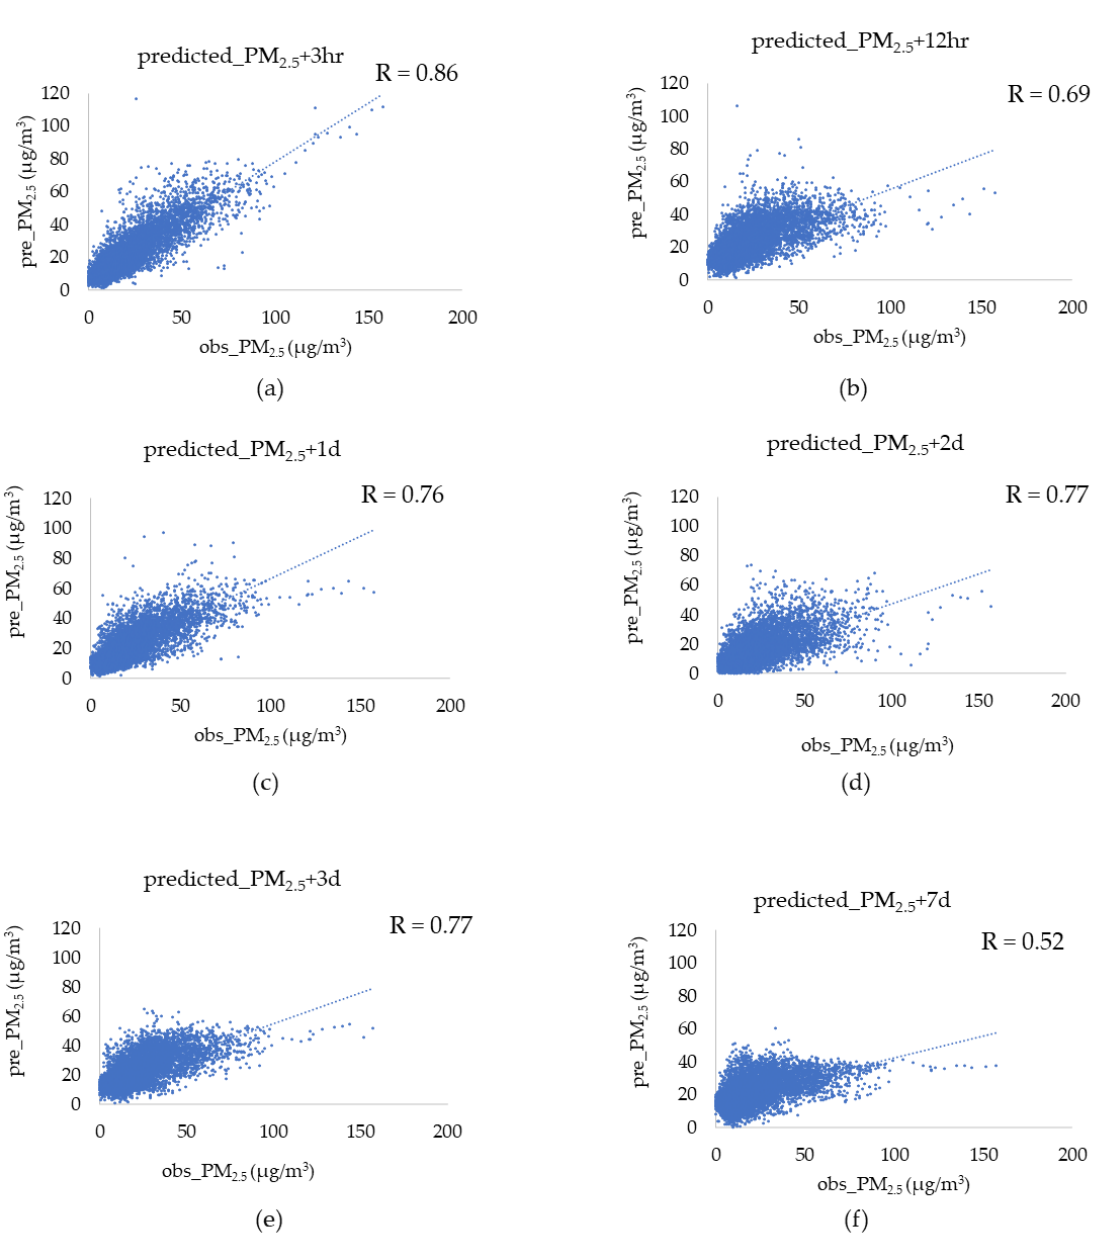
Figure 5. Quality of predictions (R) of PM 2.5 concentrations for up to 7 days using multiple linear regression compared with observed PM 2.5 data. Forward prediction for: ( a ) 3 h, ( b ) 12 h, ( c ) 1 day, ( d ) 2 days, ( e ) 2 days, ( f ) 7